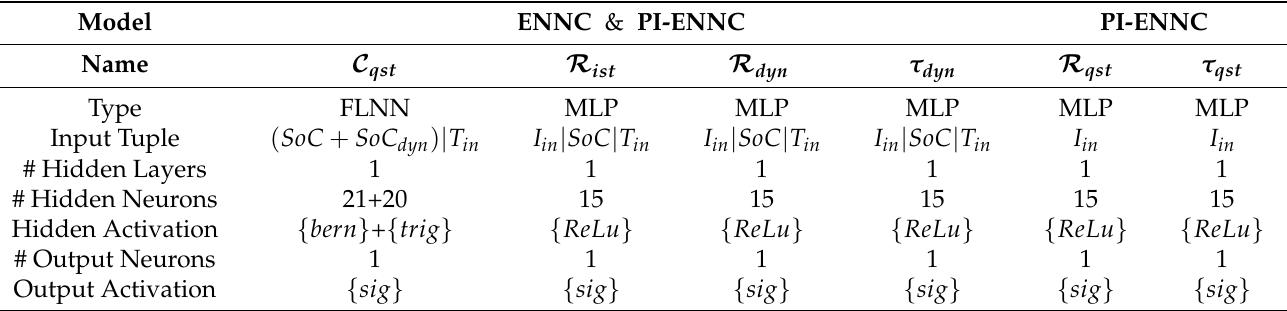
Table 3. PI-ENNC and ENNC